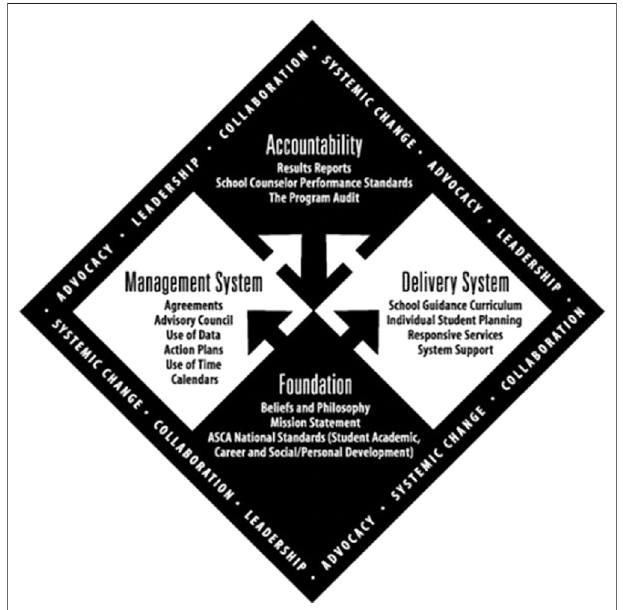
FIGURE1| TheASCANationalModelDiagram(thirdEdition).SOURCE: Reprinted with permission from the American School Counselor Association.